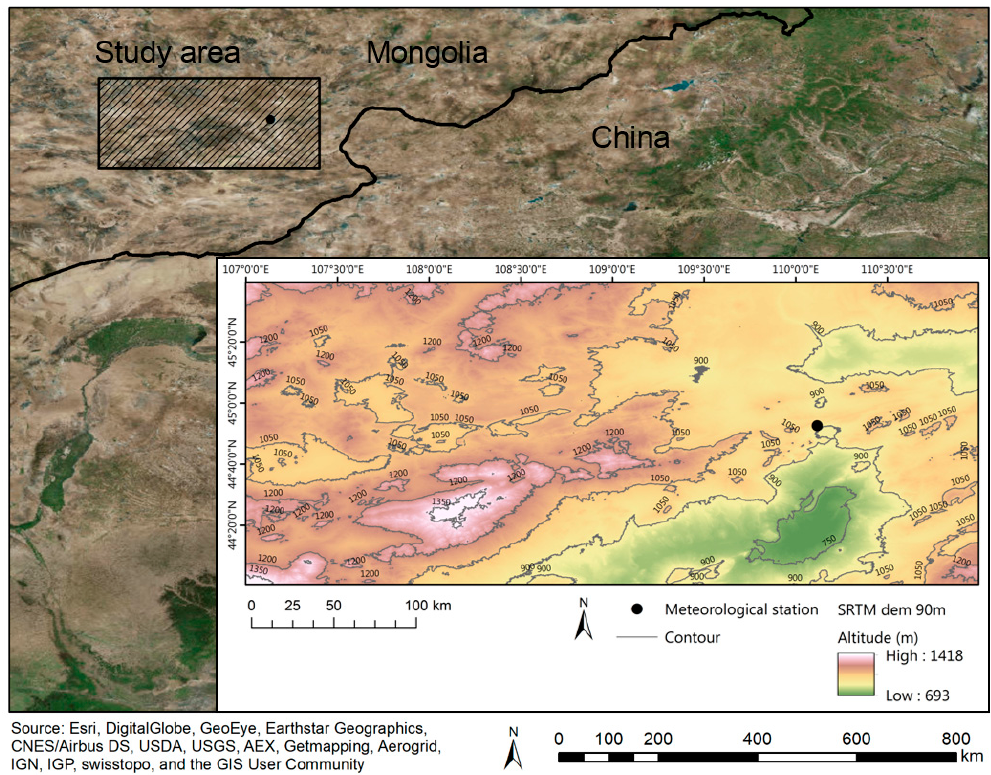
Figure 1. Map of the study area. The altitude in the area is 1030 ± 130 m. Mountains and valleys are common geographical features in the area.